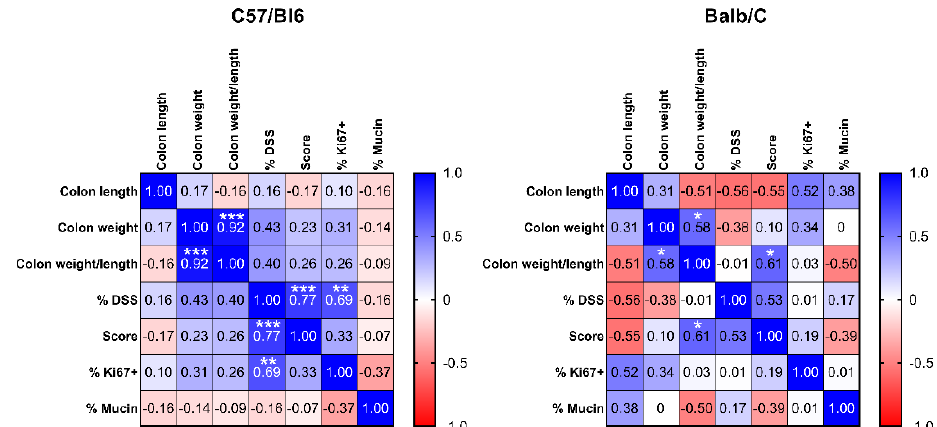
Figure 2. Effect of DSS treatment on percentage of Ki67 positive cells ( a , b ), and mucin content ( c , d ) in colons of 14-month-old female C57/Bl6 and Balb/C mice with CAC induced by 3 different concentrations of DSS. Control = untreated control mice of the same age. N = 2–4. * p < 0.05, ANOVA with Dunnett post hoc test vs. Control for C57/Bl6. Statistical correlation analysis is provided in Figure 3.